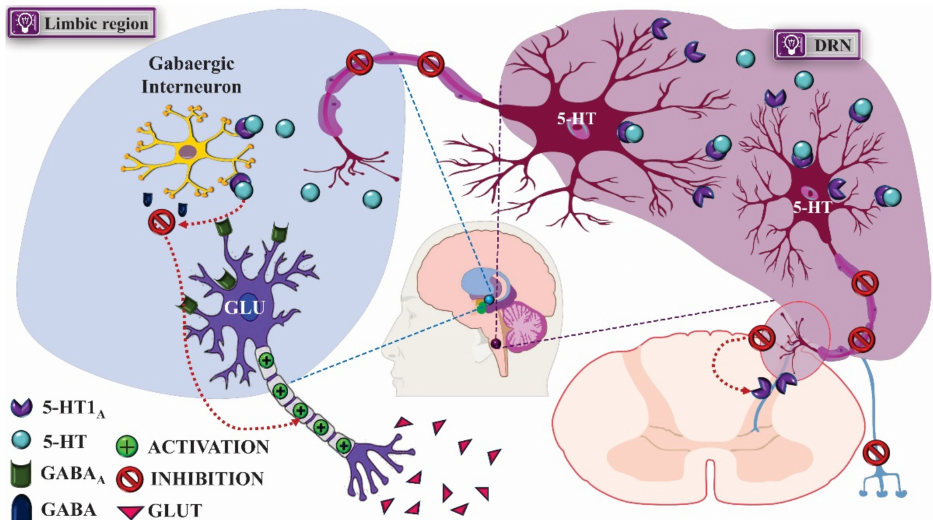
Figure 4. Hypothetical scheme of serotonergic projections resulting from the raphe and innervation of the dorsal horn spinal neurons (DHS) and limbic regions. In the dorsal raphe nucleus (DRN), 5-HT 1A receptors activate G protein- controlled internal rectifying potassium channels (GIRK) by releasing G βγ subunits of the G α i/0 protein, leading to intracellular potassium (K + ) efflux, hyperpolarization of target neurons, and, finally, inhibition of the local neuronal activity. Hippocampus and cortex heteroreceptors are also coupled to GIRK channels. Thus, activation of both 5-HT 1A autoreceptors and the hippocampus and cortex heteroreceptors increases the GIRK current, leading to neuronal hyperpolarization. As shown in the figure, the activation of 5-HT 1A autoreceptors reduces the release of serotonin (5-HT) in limbic regions or in DHS. However, the activation of 5-HT 1A heteroreceptors located in the DHS reduces the release of local 5-HT, consequently decreasing the release of nociceptive neurotransmitters and reducing pain signals (antinociceptive effect). In limbic regions, the stimulation of these receptors activates GIRK in GABAergic interneurons, hyperpolarizing them and consequently decreasing the influence of GABA on local glutamatergic neurons. As a consequence, there is an increase in the excitatory glutamatergic influence on underlying dopaminergic neurons